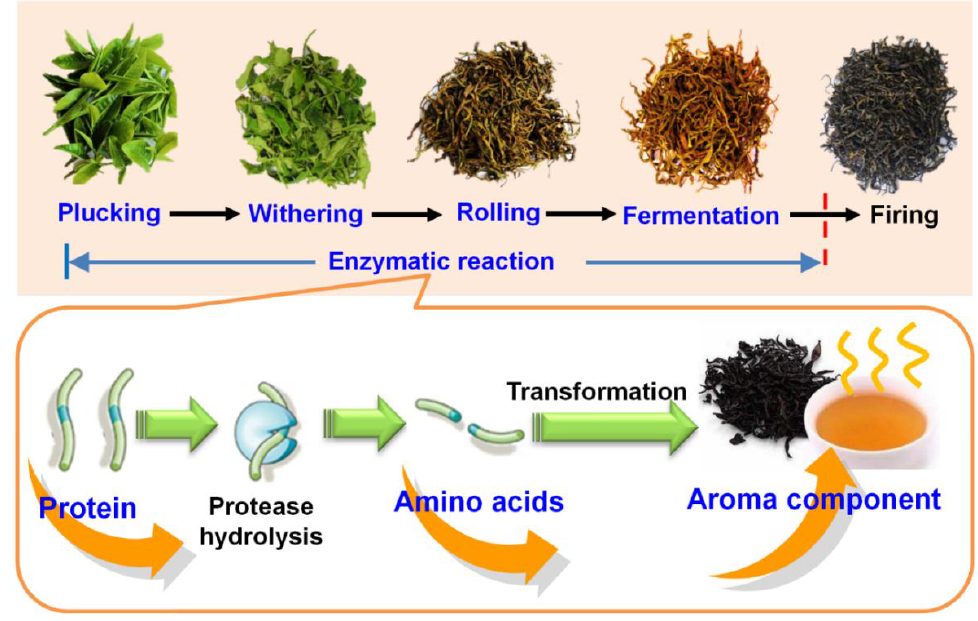
Figure 5. Summary on enzymatic reaction related protein degradation and proteinaceous amino acids metabolism during the black tea ( Camellia sinensis ) manufacturing process. Supplementary Materials: The following are available online at www.mdpi.com/xxx/s1. Table S1. The changes of water content in tea leaves during black tea manufacturing process. Table S2: Contents of free amino acids in tea leaves of simulated the black tea fermentation. Figure S1. GC-MS chromatograms of aroma compound in tea leaves during black tea manufacturing process.